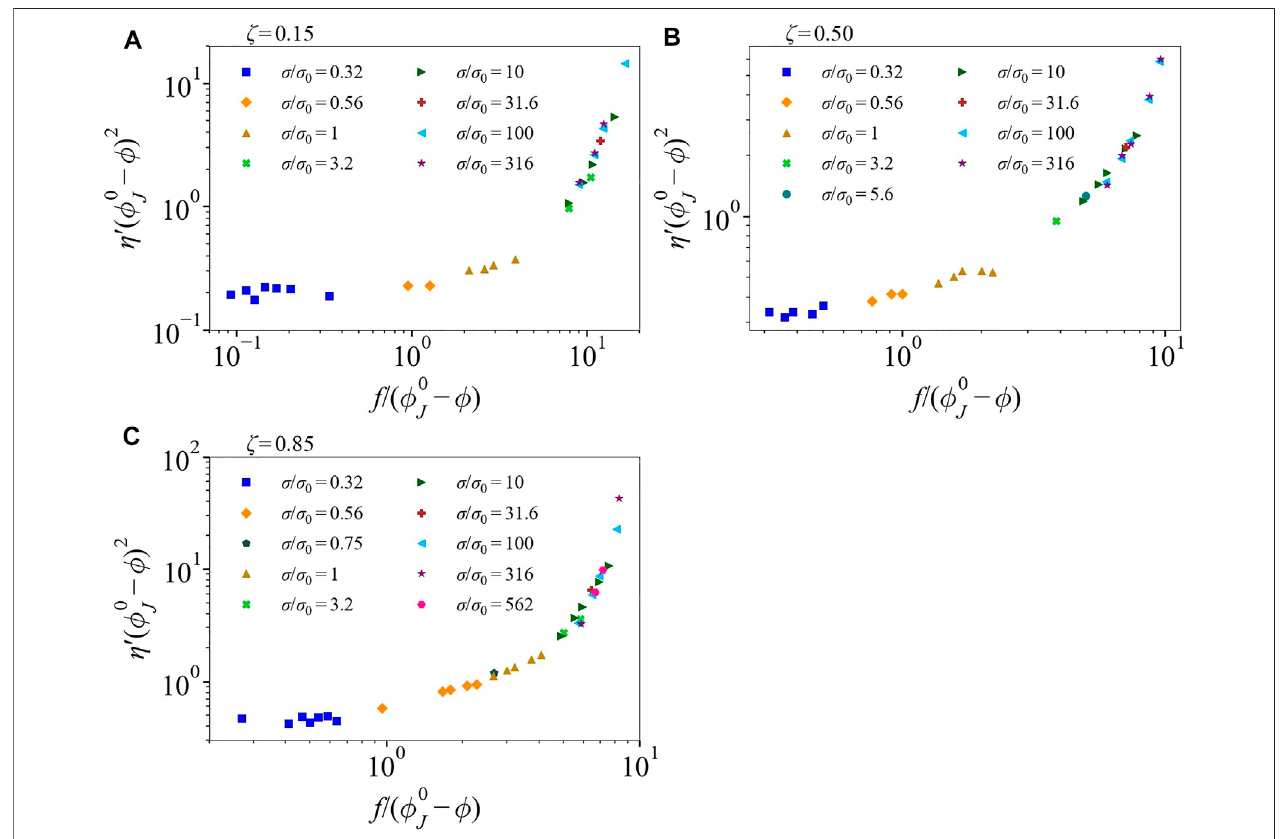
FIGURE 4 | The scaling function F η (cid:1) η ′ ( ϕ 0 J − ϕ ) 2 plotted as a function of the scaling variable x = f /( ϕ 0 − ϕ ) for bidisperse suspensions at δ = 3 and varying large particlefraction (A) ζ =0.15 (B) ζ =0.50, (C) ζ =0.85over0.54 ≤ ϕ ≤ 0.60and0.32 ≤ σ / σ 0 ≤ 562.For ζ =0.15,theformof f isexponential f ( σ )=exp( σ */ σ )with σ *=1.45,for ζ = 0.50 and 0.85, it is fi tted manually f = f fi t